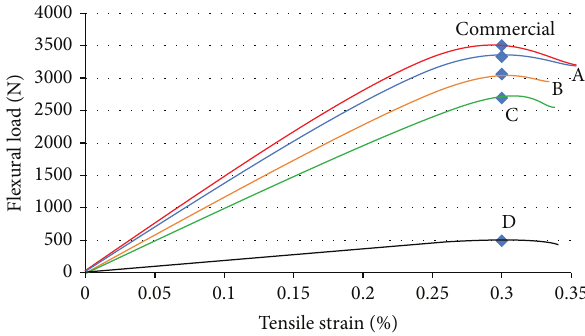
Figure 6: Flexural load against tensile strain of lightweight cube concrete with different ratio of WLA to cement (wt/wt): (A) 55%, (B) 60%, (C) 65%, and (D) 70%.